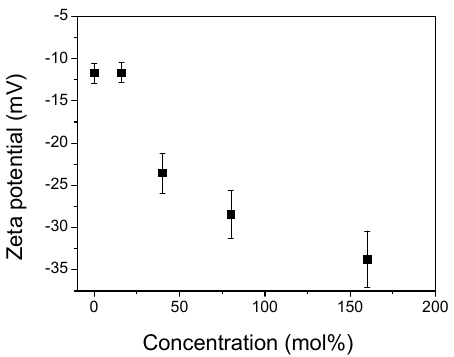
Figure 5. Zeta potential (ZP) of the DPPC liposomes (0.08 mg / mL) versus an increasing TS concentration. Error bars are equal ± SD calculated for three different repetitions.